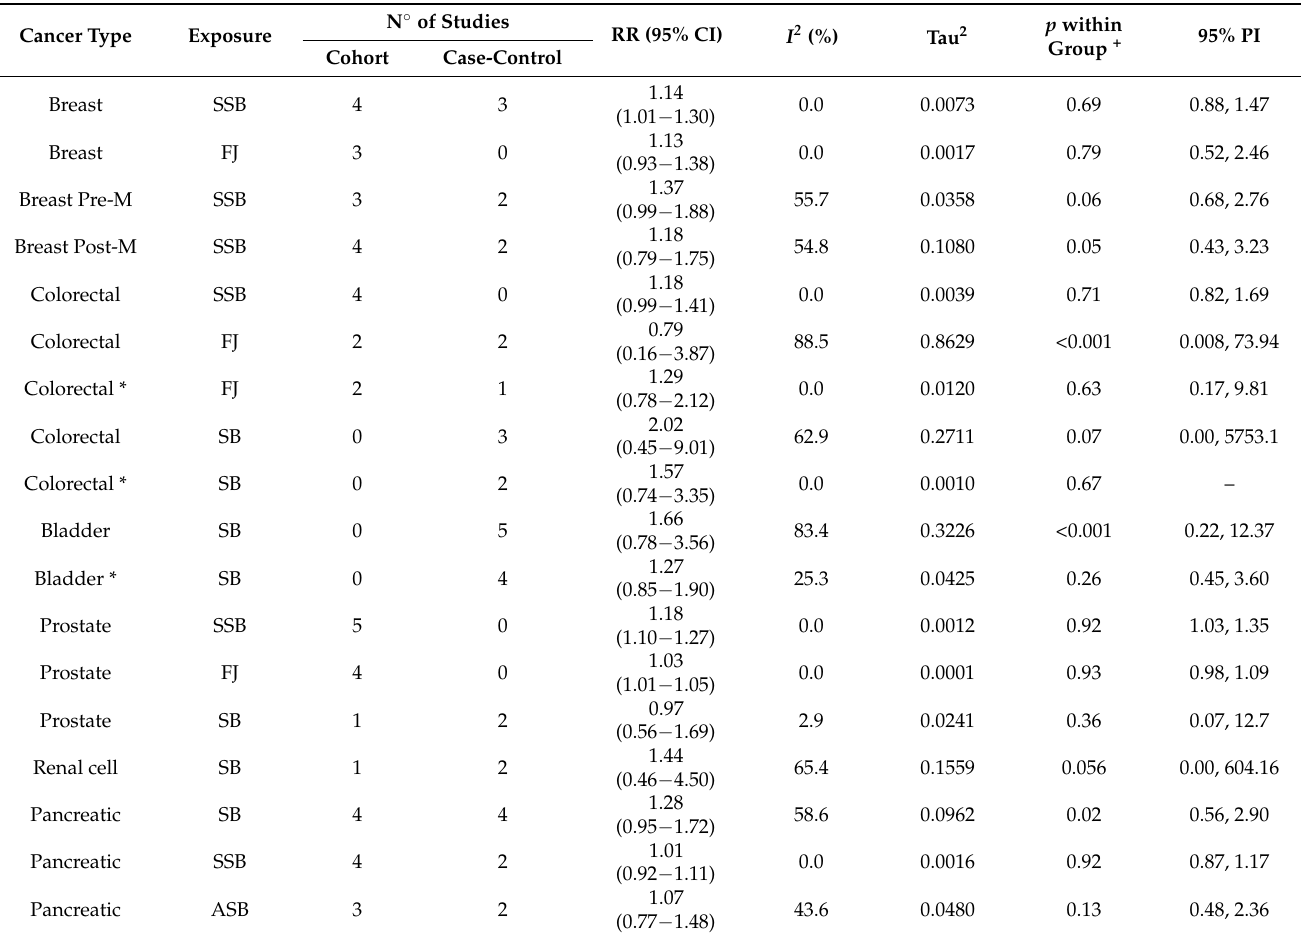
Table 2. Summary of the results of the meta-analysis (random effects